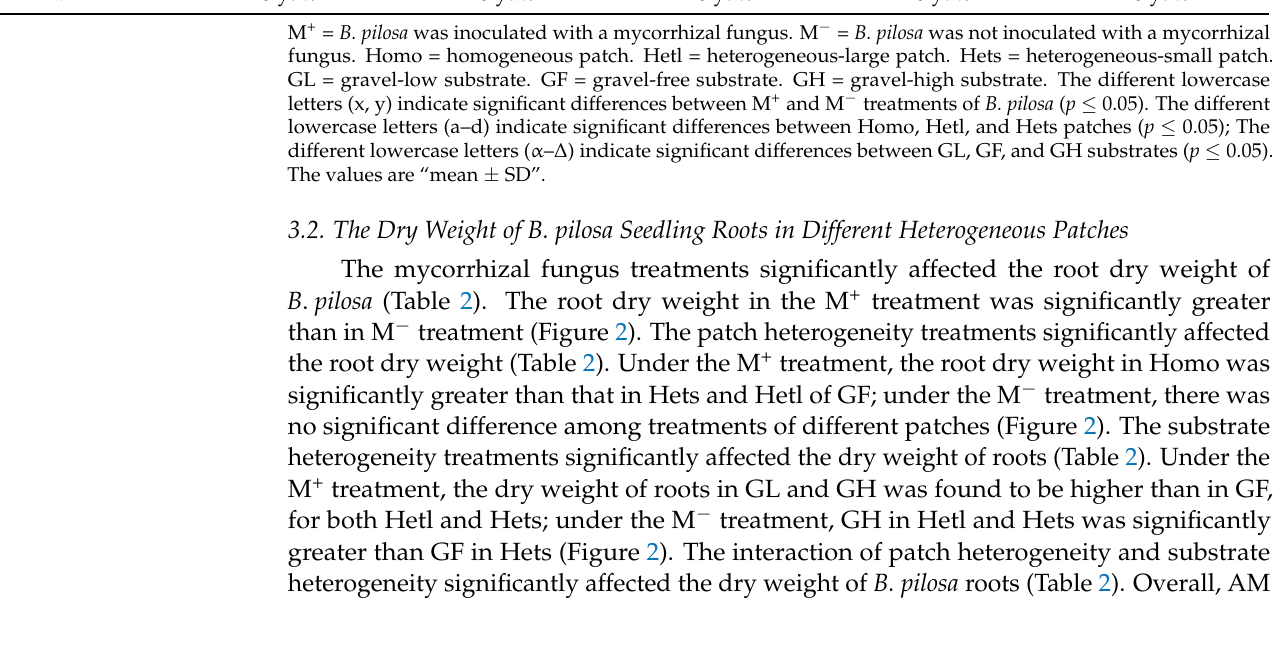
Table 1. The root mycorrhizal colonization rates (%) of Bidens pilosa . Homo Hetl Hets Treatments GL